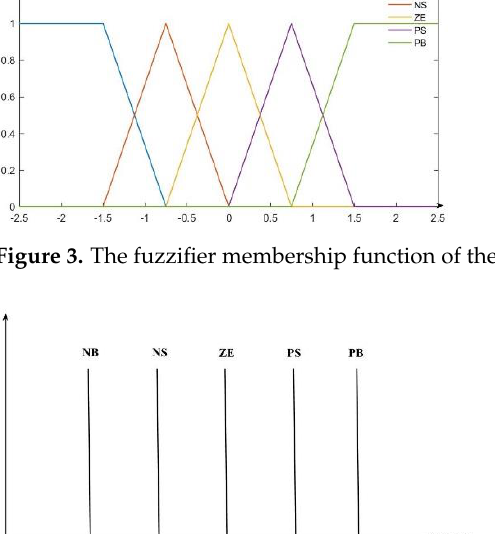
Figure 4. The defuzzifier membership function of the traditional fuzzy controller. Table 3. The rule table for the traditional fuzzy controller for ( i = 1, 2, 3).